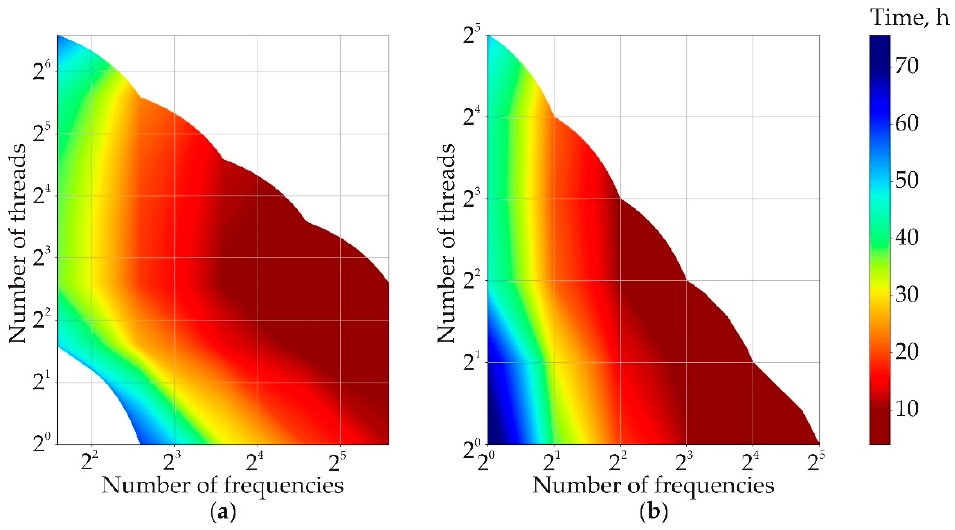
Figure 5. Performance analysis results for the algorithm of simulating the sounding process with a pulsed current source: ( a ) on the KNL nodes; ( b ) on the Broadwell nodes. pulsed current source: ( a ) on the KNL nodes; ( b ) on the Broadwell